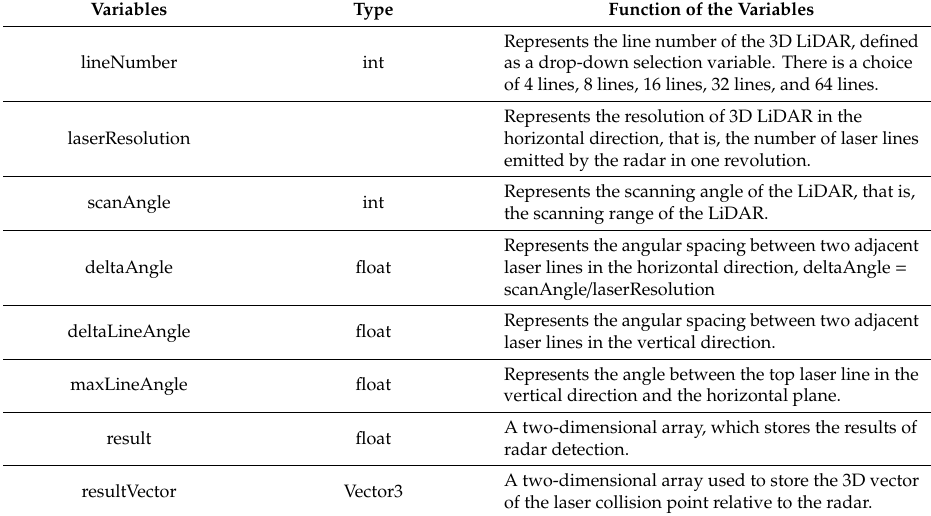
Figure 5. Three-dimensional LiDAR photos: ( a ) Velodyne VLP-16 LiDAR; ( b ) Velodyne HDL-64E LiDAR; ( c ) RoboSensep’s RS-LiDAR-32. Table 3. Definition of variables for 3D LiDAR simulation.